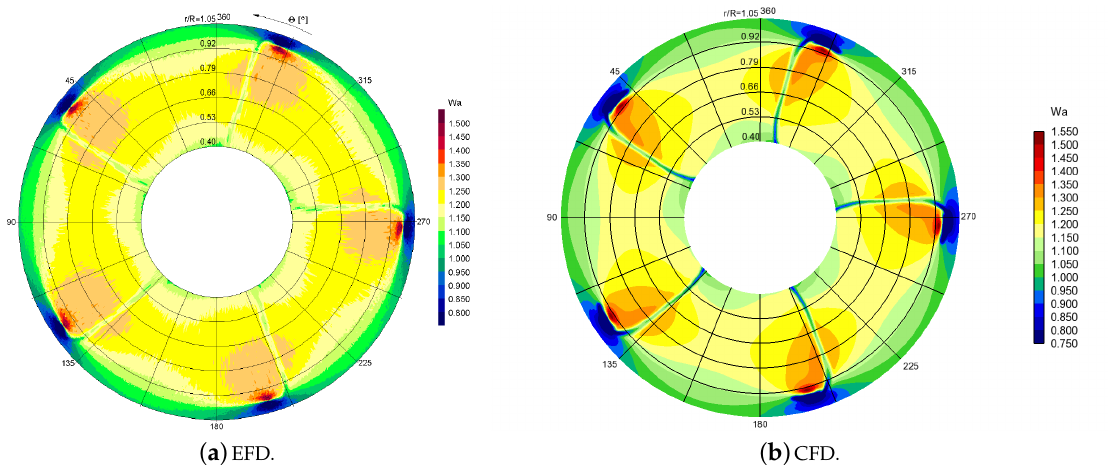
Figure 10. Comparison of axial wake distributions at x / D = 0.16 behind the